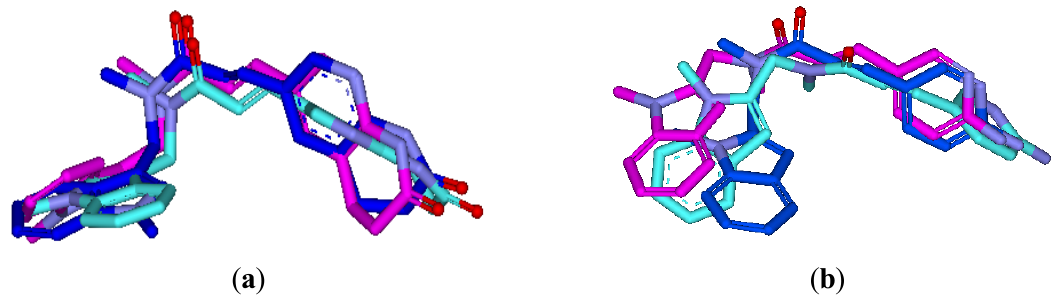
Figure 2. The best pharmacophore mapping conformation (purple stick) and the docking conformation with the highest ChemScore (cyan stick) are superimposed on the bound conformation in the crystal structure (blue stick). ( a ) For compound 20 ; ( b ) for compound 9 .